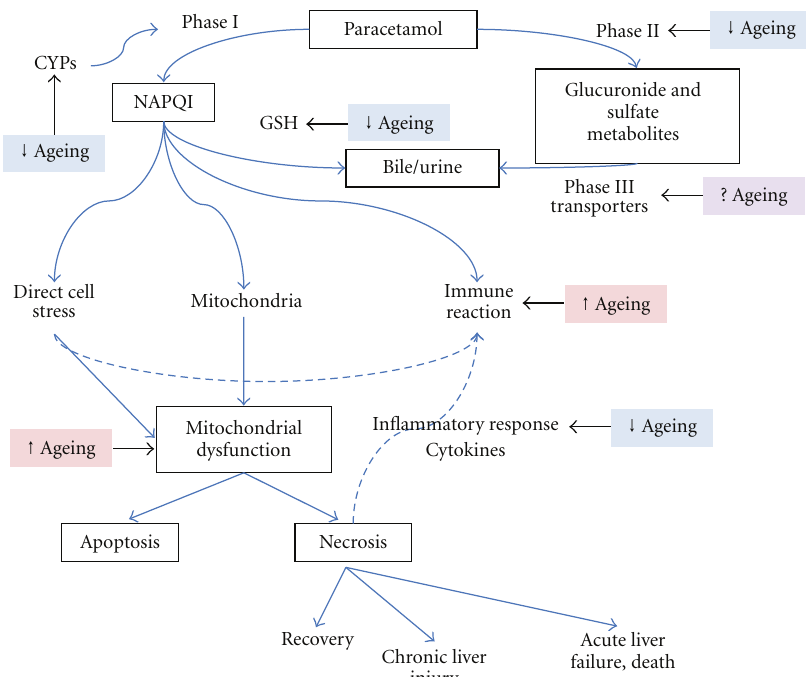
Figure 4: The e ff ect of age on the hepatotoxic pathway for paracetamol-induced liver injury. At therapeutic doses, paracetamol metabolised primarily in the livervia the Phase II metabolism (conjugation). A small amount of drug undergoes Phase I CYP450- (CYP-)mediated N-hydroxylation to form N-acetyl-p-amino-benzoquinone immine (NAPQI), a toxic metabolite which is conjugated with hepatic glutathione (GSH) and is neutralised. The major metabolites are excreted via the urine or bile by Phase III transporters. Saturation of conjugation pathways results in increased use of the CYP450 pathway, increased NAPQI formation, and increased depletion of hepatic glutathione. NAPQI can cause injury through direct cell stress, direct mitochondrial inhibition, or through immune reactions. Initial injury leads to mitochondrial dysfunction leading to either apoptosis of damaged cells, or necrosis with recovery, chronic liver injury or actual liver failure, and death as potential outcomes. Additionally, necrosis can stimulate the inflammatory response leading to cytokine release and further potentiation of the immune reaction. Ageing can act at multiple parts of the pathway to either increase ( ↑ ) or decrease ( ↓ ) susceptibility to hepatotoxicity. It must be noted, however, that this is likely to vary between individuals. The e ff ect of ageing on Phase III transporters is somewhat unknown (?) in humans. Picture adapted from Russmann et.al., 2009